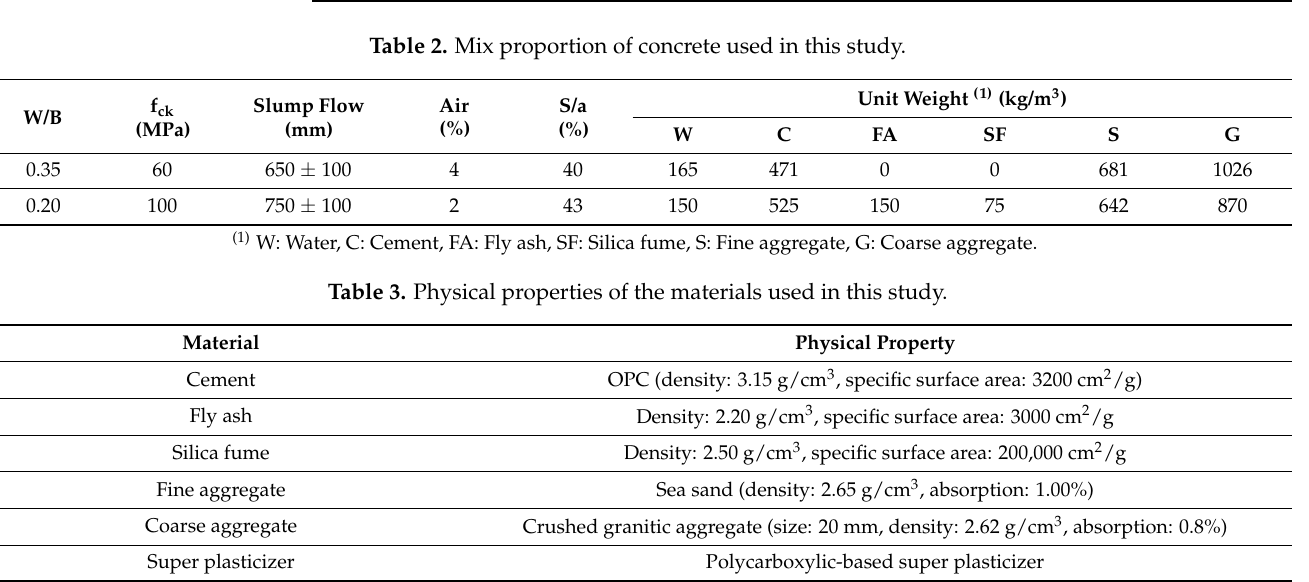
Table 2. Mix proportion of concrete used in this study.